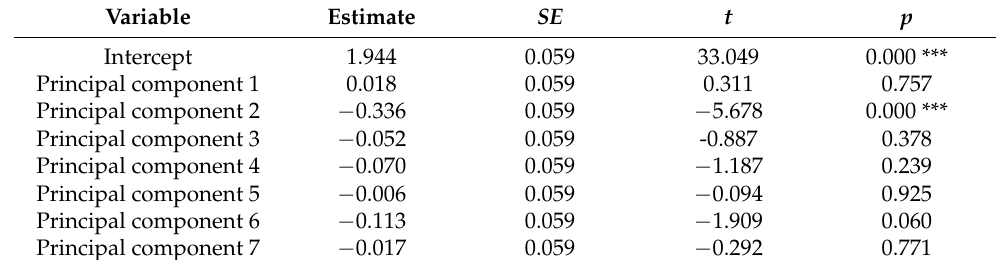
Figure 1. Distribution of Emberiza aureola taxon recordings from nine Table 1. GLM results obtained by extracting principal components for all song parameters of subspecies. populations used in the subspecies vocal divergence analysis, with sampling sites indicated by different symbols. Squares represent E. a. aureola (population 1 = Sverdlovsk Oblast, Russia; 2 = Qinghe County, Xinjiang Province, China; 3 = Buryatiya, Russia; 4 = Lake Baikal, Russia), circles represent E. a. ornata (population 5 = northeastern and eastern Mongolia; 6 = Zhalong, Heilongjiang Province, China; 7 = Muraviovka Park, Russian Far East; 8 = Khasyn, Magadanskaya Oblast, Russia), and the triangle represents E. a. insulana (population 9 = Toyotomi, Hokkaido, Japan). Different colors and numbers represent different populations marked in the legend.